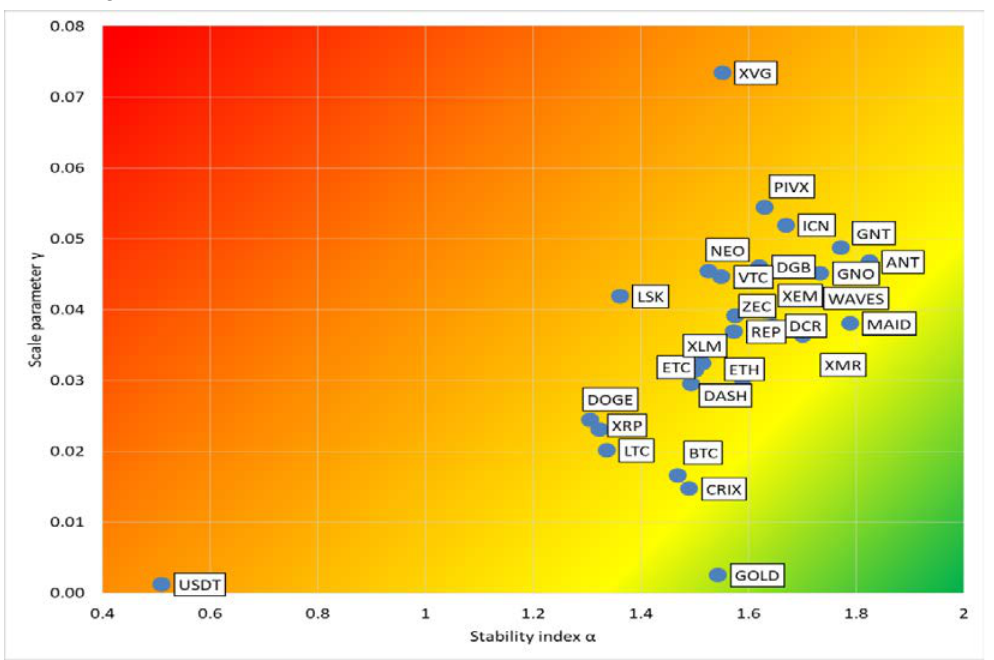
Figure 2 : Heatmap of scale parameter γ versus stability index α for selected